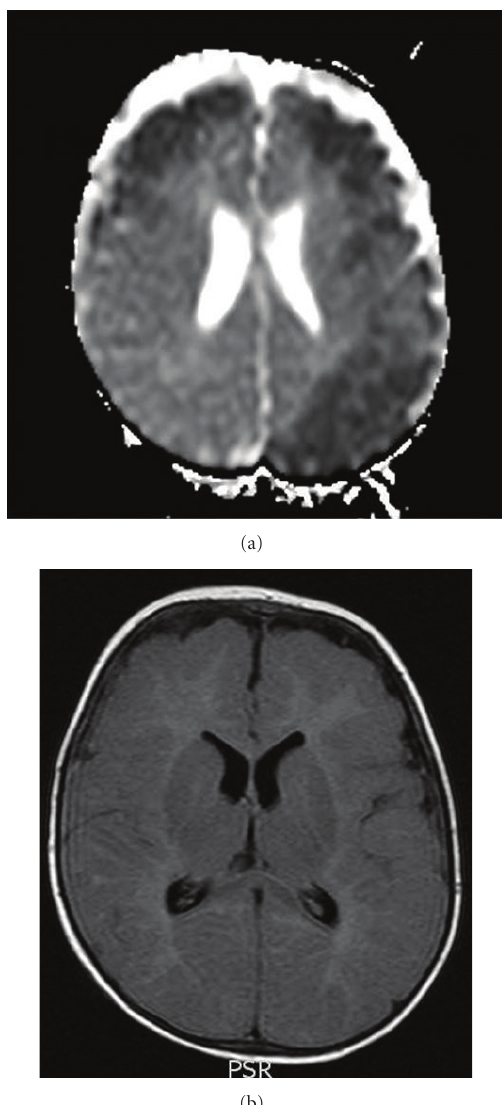
Figure 1: (a), (b) Brain magnetic resonance imaging one day after admission. (a) Axial apparent di ff usion coe ffi cient (ADC) map shows large areas of cortical and subcortical restricted di ff usion in the frontal areas bilaterally, left parietal and left temporal regions, suggestive of encephalitis. (b) Fluid attenuated inversion recovery (FLAIR) sequence showing normal brain